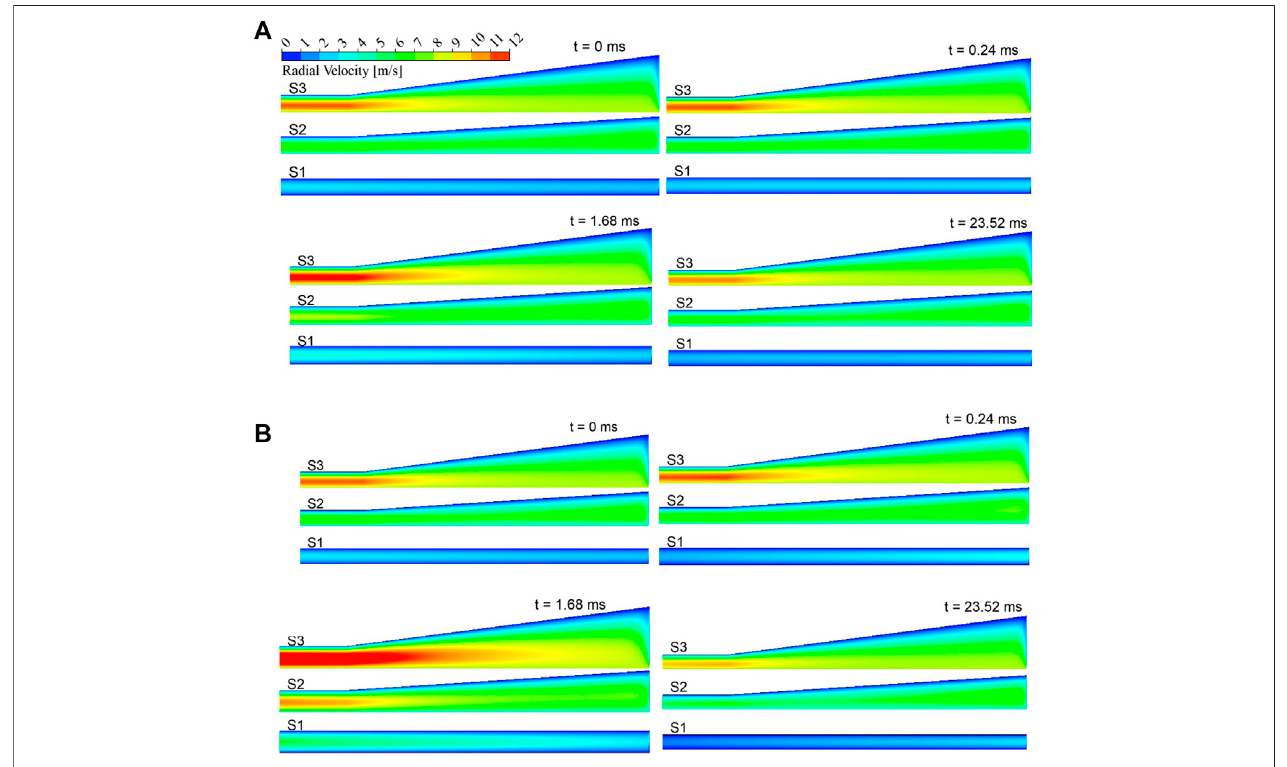
FIGURE 9 | Radial velocity distribution varies with time (A) a = 4% and (B) a = 10%.